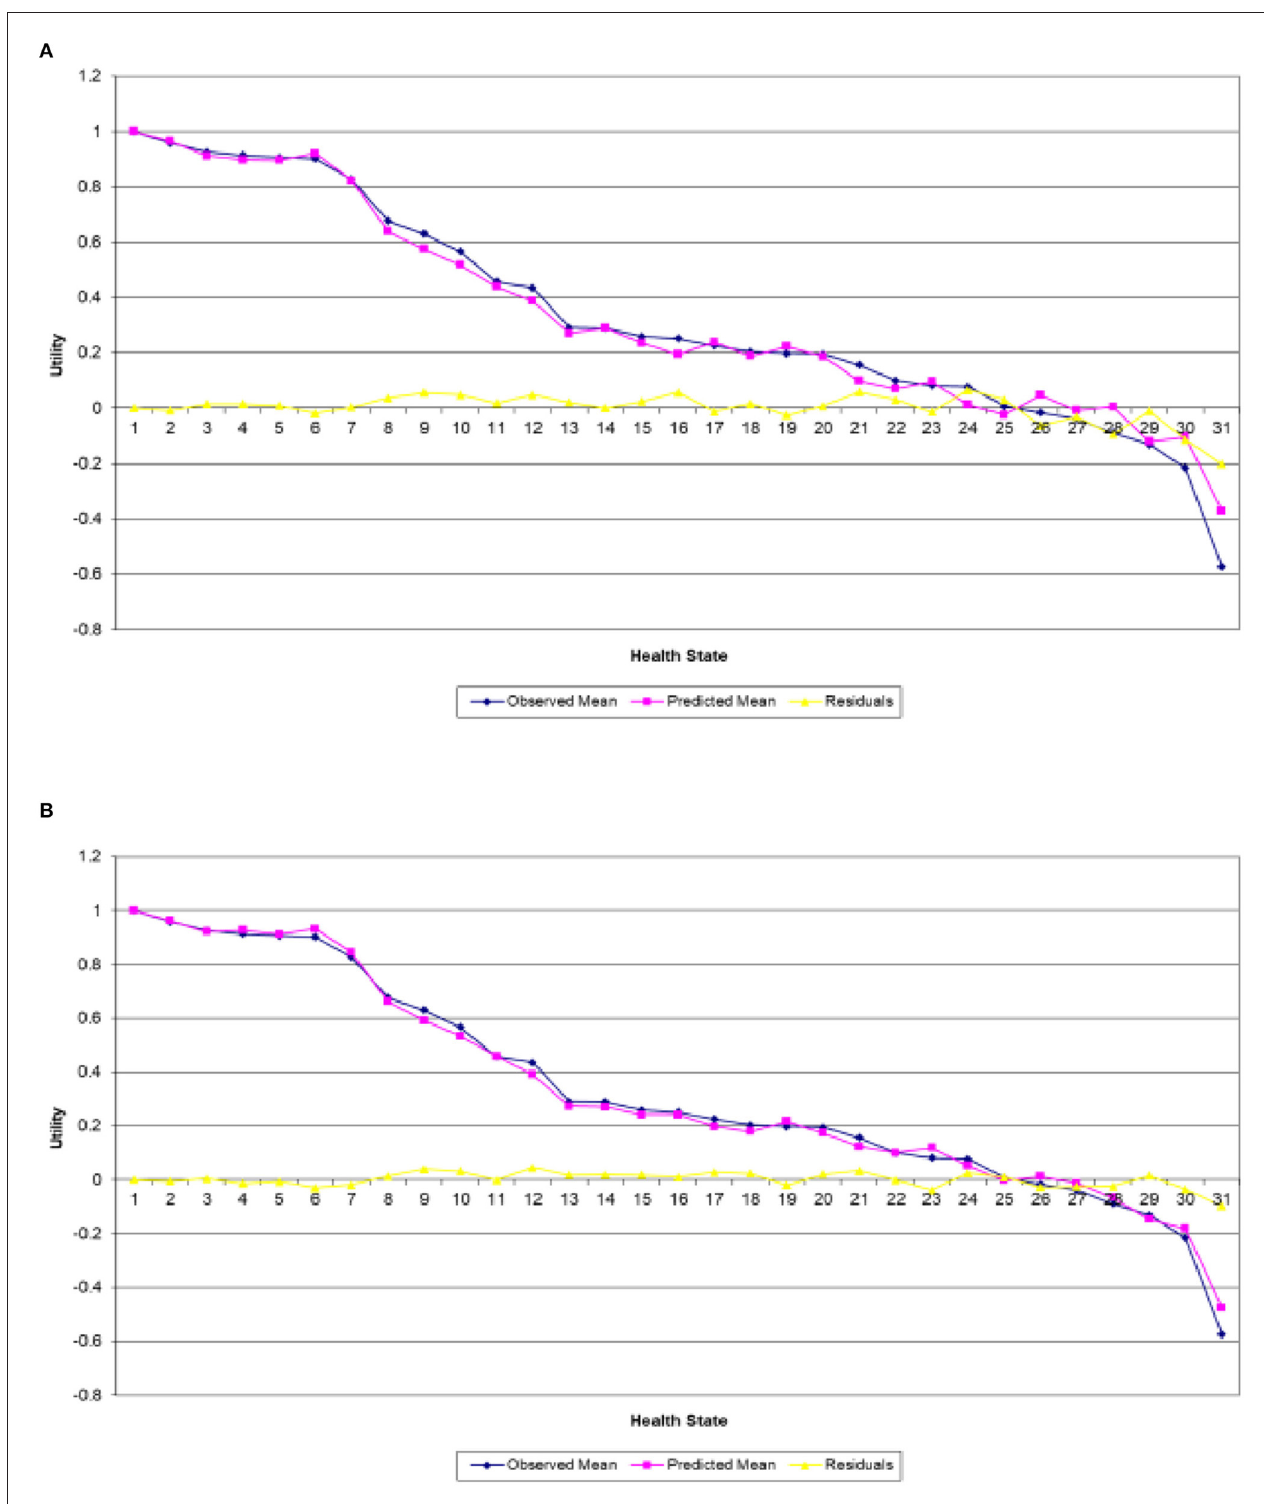
FIGURE 3 | Actual and predicted mean health states valuations generated from analyzing (A) Polish data only and (B) Polish data with Irish results as informative priors.